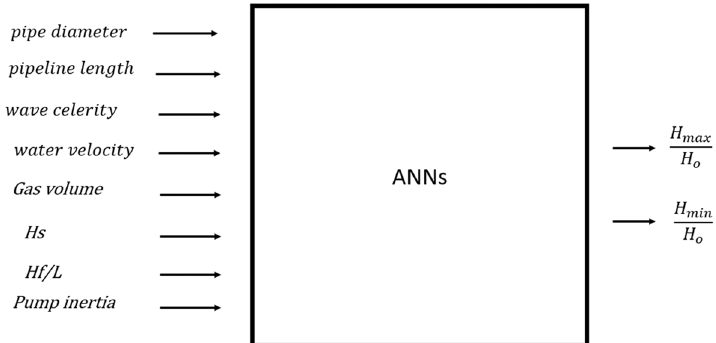
Fig. 3 Inputs and outputs for the 1st artificial neural network